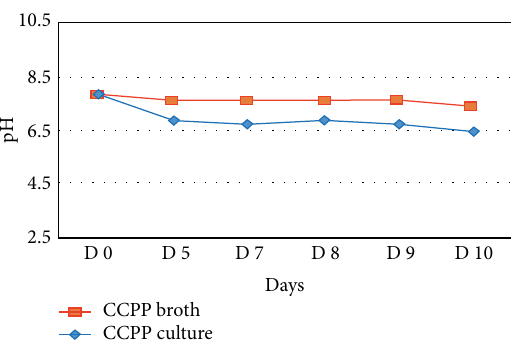
Figure 1: pH in media culture during the growth period of Mccp.